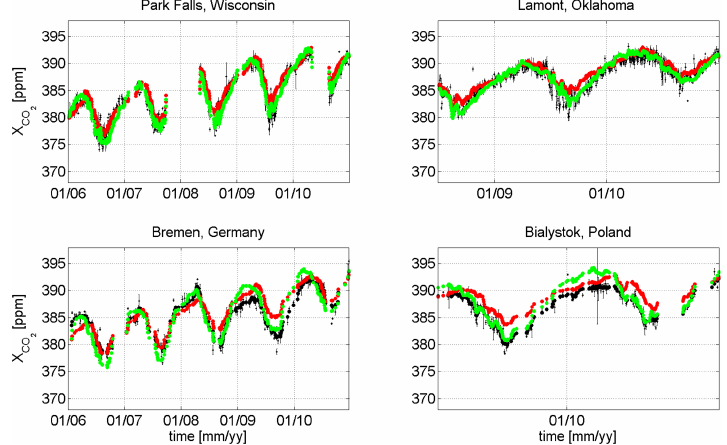
Fig. 6. Weekly averaged GEOS-Chem CO 2 simulations using CASA NEE estimations (red dots) and SiB NEE inputs (green dots) in comparison with weekly averaged TCCON measurements at four sites: Park Falls (Wisconsin), Lamont (Oklahoma), Bremen (Germany), Białystok (Poland).